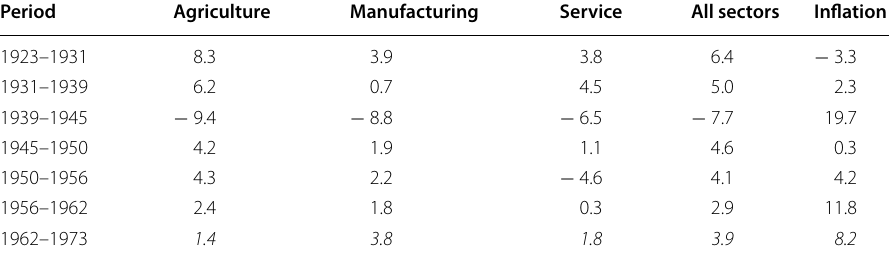
Table 4 Productivity growth in agricultural, manufacturing, service, and all sectors (annual rate, unit: %). Source : Author’s calculation. Employment data was derived from TurkStat (employed persons by type of economic activity). Productivity growth was cal- culated by deriving sectoral data from the Ministry of Development’s report (Economic and Social Indicators between 1923 and 2014) and calculated with real outputs. Inflation was derived from TurkStat (consumer price). The inflation data between 1923 and 1939 replaced with wholesale price index